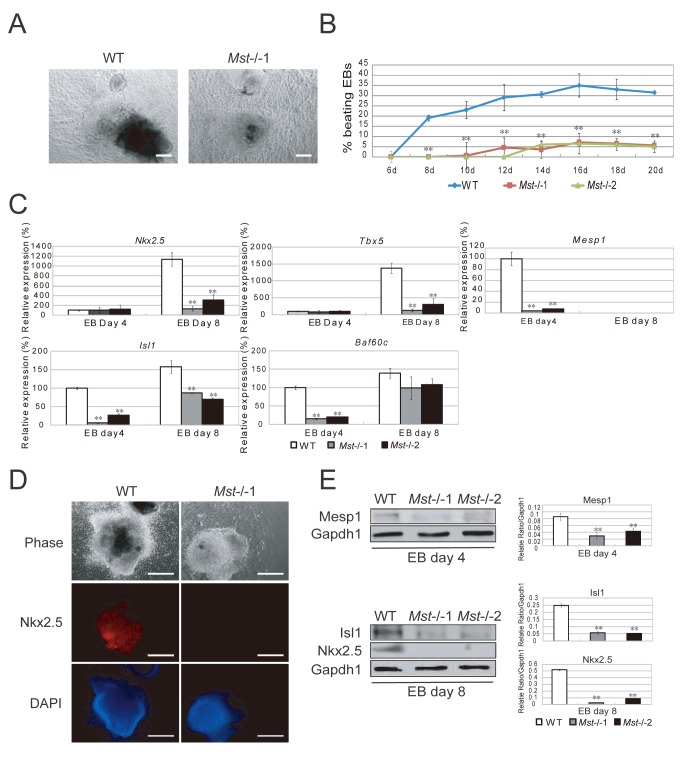
ES cell to cardiac progenitor cell differentiation is disturbed by Mst1/Mst2 depletion.(A) Phase contrast pictures of differentiated wild type EBs and Mst-/- EBs in cardiac differentiation medium. Scale bar, 200 μm. (B) Percentage of spontaneously beating EBs determined from day 6 to day 20 during differentiation (n>100 per time point). Mst-/-EBs showed a significant less beating EBs than wild type EBs. Experiments were performed in triplicate, and error bars represent SD. Statistically significant differences are indicated (*, P<0.05; **, P<0.01; ***, P<0.001). (C) Relative mRNA levels of cardiac progenitor cell markers Nkx2.5, Tbx5, Mesp1, Isl1 and Baf60c in wild type and Mst-/- EBs at day 4 and day 8 during EB formation. Actin was used as an internal control. The data are shown as the mean ± S.D (n=3). Statistically significant differences are indicated (*, P<0.05; **, P<0.01; ***, P<0.001). (D) Immunofluorescence stain with antibody against Nkx2.5 to examine cardiac progenitor marker Nkx2.5 expression in the wild type EBs and Mst-/- EBs in cardiac differentiation medium for 8 days. Scale bar, 200 μm. (E) Immunoblotting and denstitometric analysis with antibody against Mesp1, Isl1 and Nkx2.5 to check their expression in wild type EBs and Mst-/- EBs in cardiac differentiation medium for 4 days or 8 days. Gapdh1 was analyzed as an internal control. The data are shown as the mean ± S.D (n=2). Statistically significant differences are indicated (*, P<0.05; **, P<0.01; ***, P<0.001).